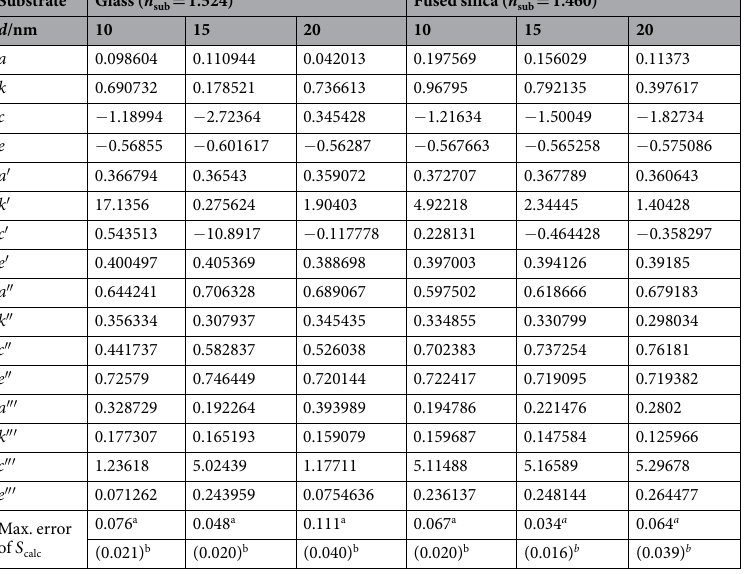
used to calculate the S calc − I sp − ξ 2 surface, as shown in Fig. 5a. Here, we used d = 20 nm and n sub = 1.524 (glass substrate). A surface plot was generated over the scattered S sim − I sp − ξ 2 dots (Fig. 2b) to allow comparison. As shown in Fig. 5a, the calculated surface closely followed the simulated dots. To verify the reproducibility of our calculation compared with optical simulations, S calc − S sim was evaluated. This result is shown in Fig. 5b. The interpolated surface in the figure was generated by the spline approximation. In the ranges of 0.69 ≤ ξ 2 ≤ 2.78 and 0.618 ≤ I sp ≤ 1.32, the error was less than 0.111 at ( ξ 2 , I sp ) = (0.69, 0.746). Furthermore, in the typical range of experimental conditions 1.6 ≤ n